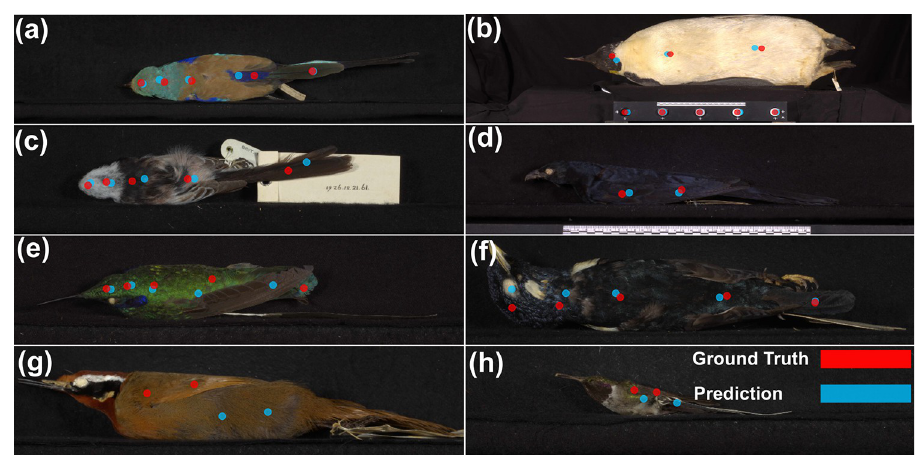
Fig 5. Example images of ground truth and predictions for the avian specimen dataset. Images (a)-(d) are correct predictions: (a) a specimen with high colour diversity, (b) a big specimen and very small reflectance standards, (c) a specimen with interferential objects such as a specimen tag, (d) a specimen which is similar to the background. Images (e)-(h) are incorrect predictions: (e) The tail is partially occluded by a wing, and it was incorrectly labelled as the wing. (f) The eye of the bird was misidentified as the crown, while the specimen was placed in a rare posture (placed on its back rather than belly) in the image. (g) The predictions of the wing were placed on the body, and the wing has a similar colour to the rest of the body regions. (h) The predictions were not placed on the wing which is very small. (Note: we cropped only focal parts of images to achieve better visualisation).